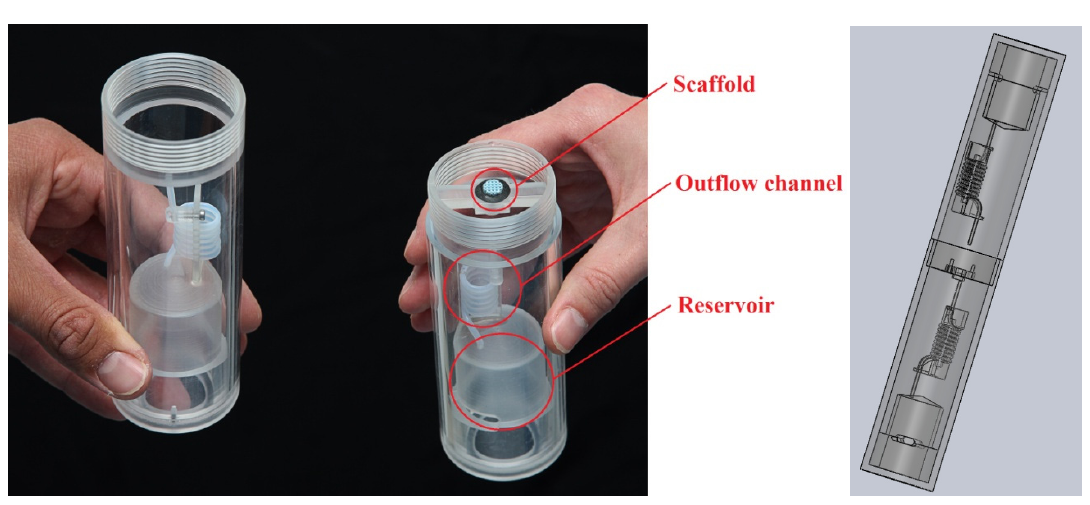
Figure 5. New design of the cell seeding